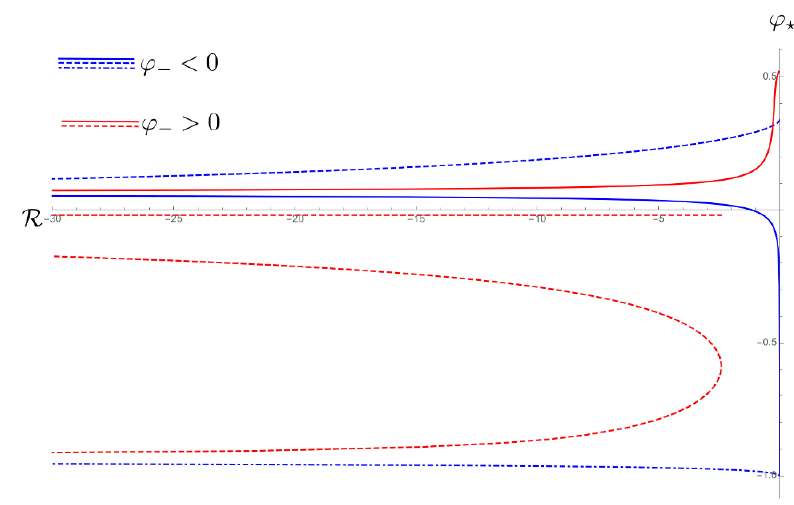
Figure 10 . Equilibrium brane position ’ ? vs. R for R < 0. Results are obtained for bulk potential (3.1), brane quantities (3.2) and parameter values (3.3). Blue lines corresponds to solutions with ’ (cid:0) < 0 while red line denotes solutions with ’ (cid:0) > 0.